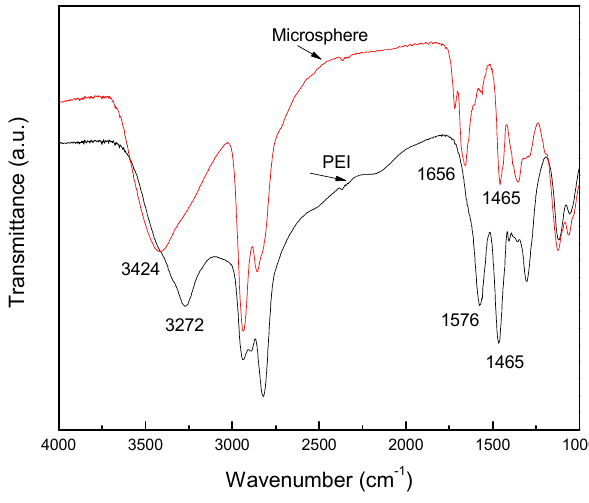
Figure 3. The FTIR spectra of PEI and the polyamine microsphere.